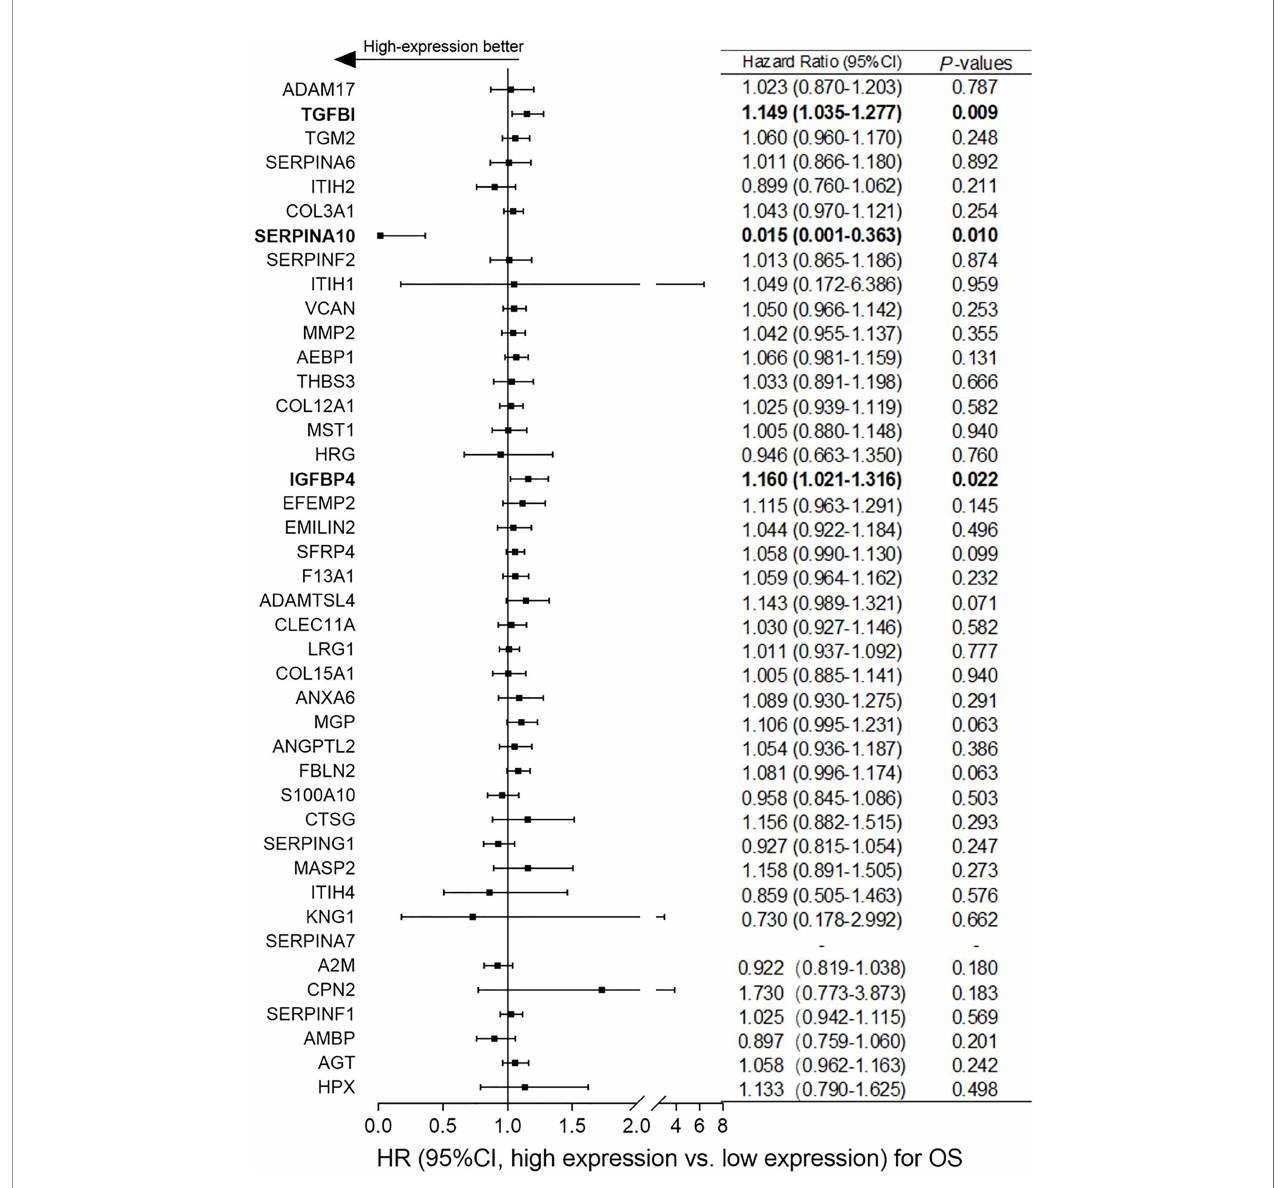
FIGURE 3 | Correlation analyses of mRNA expressions of the 42 overlapping candidate proteins and overall survival (OS) of ovarian cancer patients in The Cancer Genome Atlas (TCGA) dataset. According to the median expression level of each candidate protein, patients were assigned to high-expression and low-expression groups. Normalized expression values of RNA-sequencing data and survival data of ovarian cancer were obtained from TCGA dataset. Hazard ratio (HR) with 95% CI and p -values were generated by univariate Cox proportional hazard regression. p <0.05 was considered statistically signi fi cant. “ High-expression better ” means that ovarian cancer patients with high expression of candidate genes had better overall survival